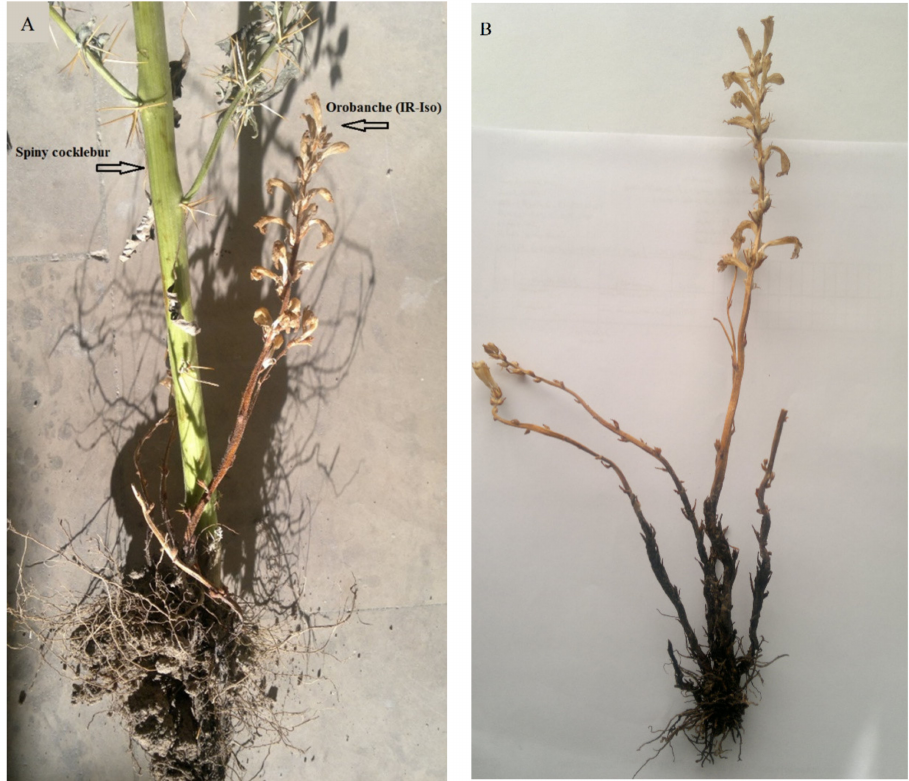
Figure 1. ( A ) The infection of a spiny cocklebur (Xanthium spinosum L.) by the collected broomrape ( Orobanche sp. ) from Iran. ( B ) Orobanche isolate detached from the roots of the host